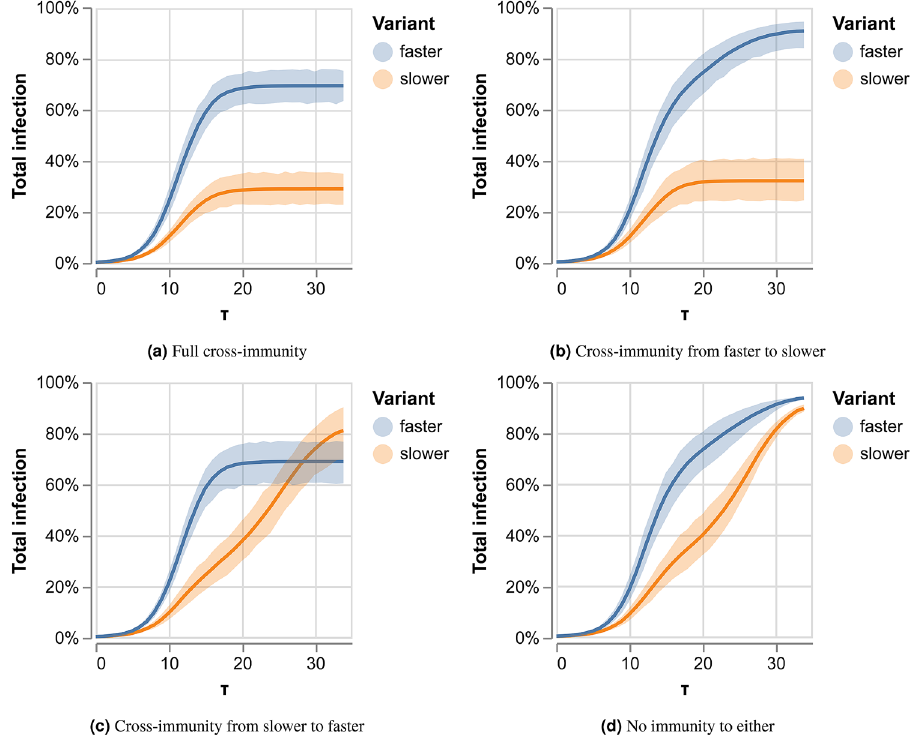
Figure 1. The aggregated percentage of infections in the population for each of the variants under ( a ) full cross-immunity (no reinfection in either), ( b ) recovery from the slower variant does not provide immunity to the faster variant, ( c ) recovery from the faster variant does not provide immunity to the slower variant, ( d ) no immunity to